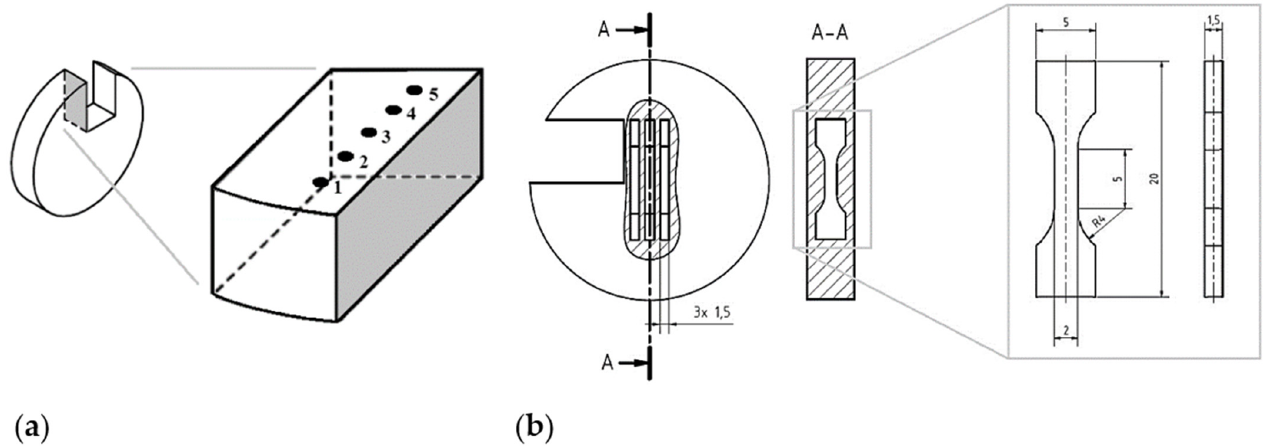
Figure 3. Cutting of the FAST sample for ( a ) measuring the surface Brinell hardness and the orientation of the cross section used for microscopic analysis (marked in grey), and ( b ) orientation of the extracted tensile specimens and their geometry, after [20].